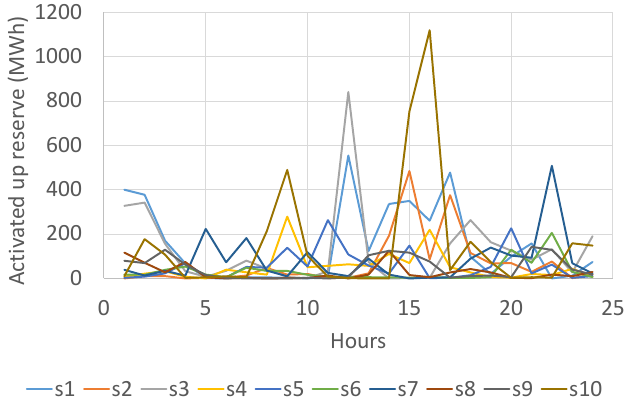
Figure 4. Up reserve activation per scenario ( R a ↑